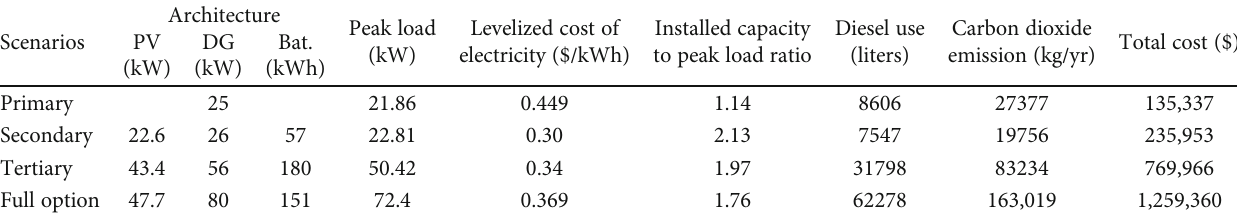
Table 10: Comparison of the best solutions for four